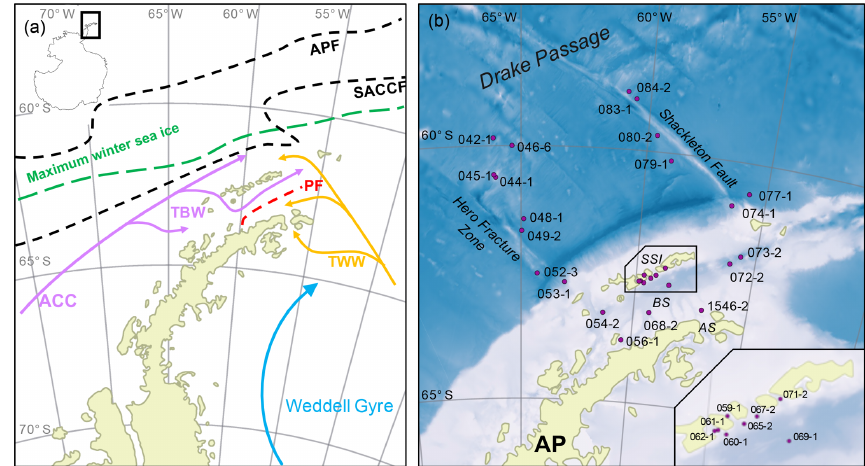
Figure 2. (a) Oceanographic setting of the study area (modified after Hofmann et al., 1996; Sangrà et al., 2011); ACC: Antarctic Circum- polar Current, TBW: Transitional Bellingshausen Water, TWW: Transitional Weddell Water, APF: Antarctic Polar Front, SACCF: Southern Antarctic Circumpolar Current Front and PF: Peninsula Front, and the maximum winter sea ice extent (after Cárdenas et al., 2018). (b) The bathymetric map of the study area with locations of all stations; AP: Antarctic Peninsula, AS: Antarctic Sound, BS: Bransfield Strait and SSI: South Shetland Islands. A detailed station map at the South Shetland Islands is integrated. The overview maps were created with QGIS 3.0 from 2018 and the bathymetry was taken from GEBCO_14 from